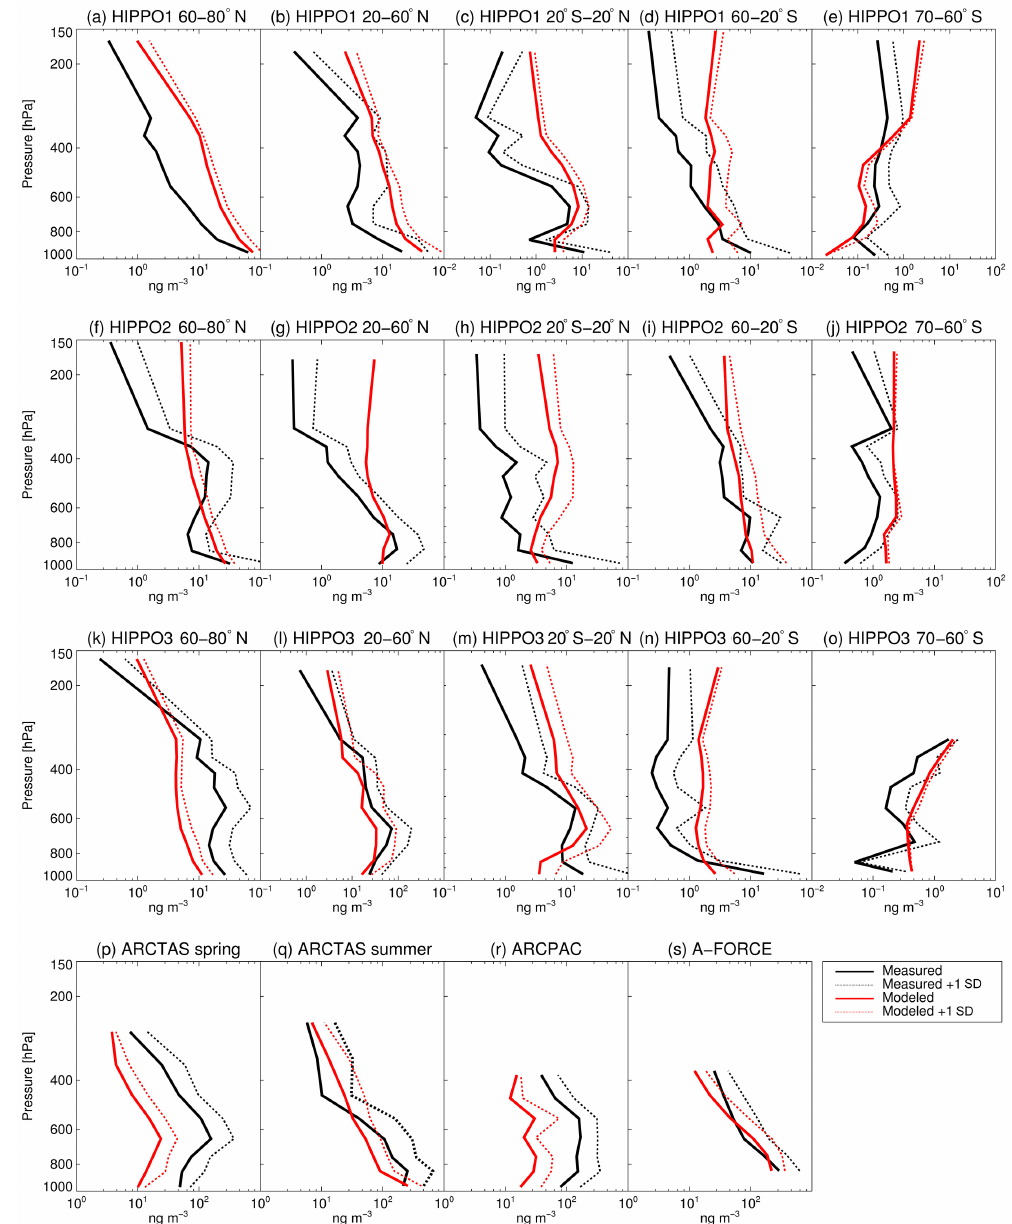
Figure 2. Comparison of modeled vertical BC profiles with measured rBC from six flight campaigns: (a–o) HIPPO 1–3, averaged over five latitude bands, (p–q) ARCTAS, spring and summer, (r) ARCPAC and (s) A-FORCE. Solid lines show the average of observations and model results binned in 100hPa intervals (25hPa for HIPPO data between 400 and 200hPa), while dashed lines show the standard deviation in each